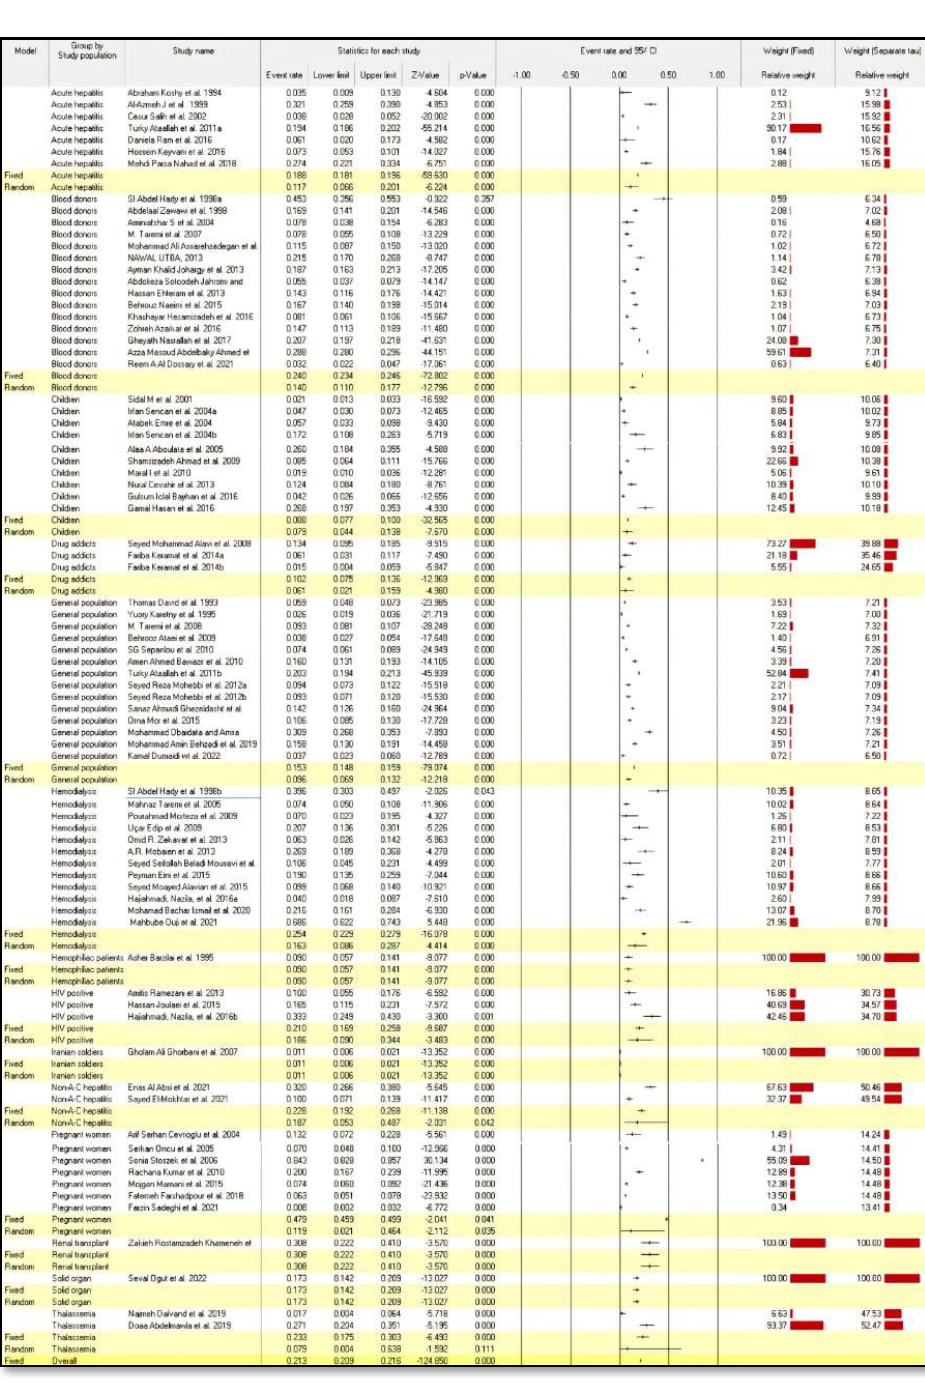
Figure 4. Forest plot meta-analysis of seroprevalence of hepatitis E virus infection by study popula-